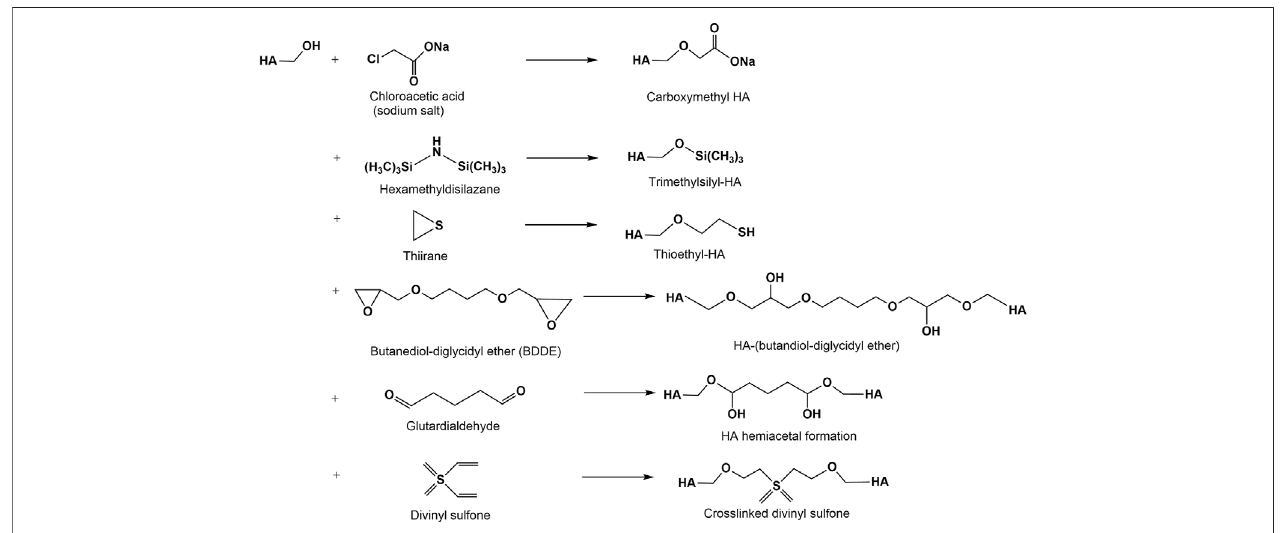
FIGURE 4 | Alkylation and bis-alkylation (crosslinking) of hydroxyl groups of HA.